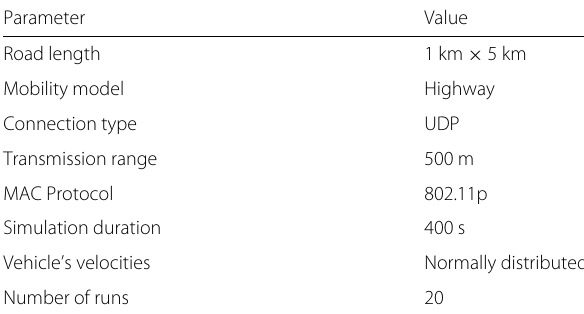
Table 2 Network simulation